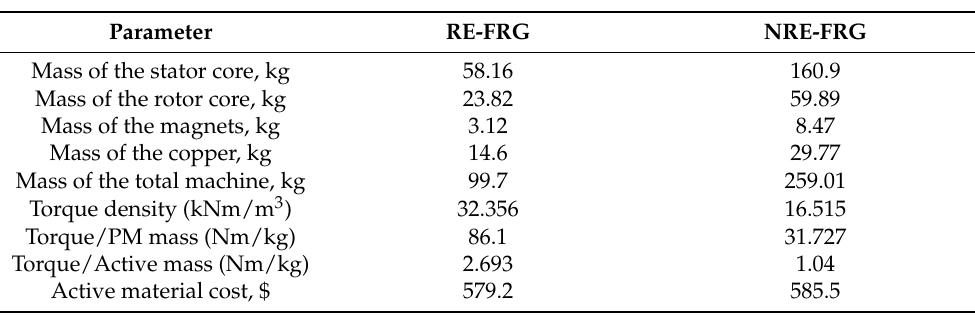
Table 4. Mass/cost